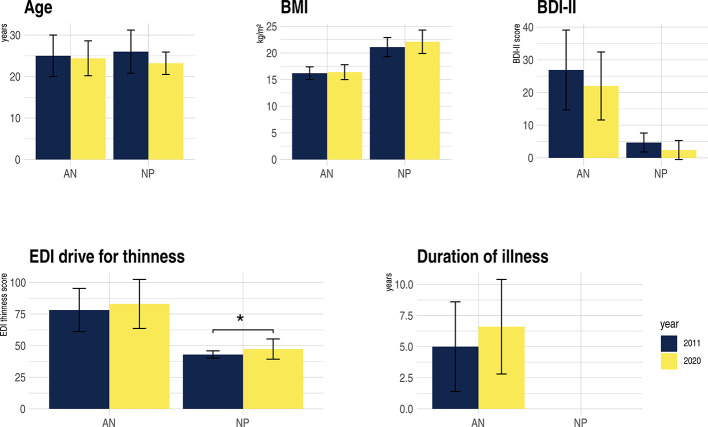
Clinical characteristics of anorexia nervosa (AN) and non-patient (NP), study sample 2011 compared to 2020. BDI-II, Becks Depression-Inventary-2; BMI, Body-Mass-Index; EDI-drive for thinness, Eating Disorder Inventory; kg, kilograms; m2, square meter; *p = 0.014. For further clinical characteristics of the replication study see
Table 1
.